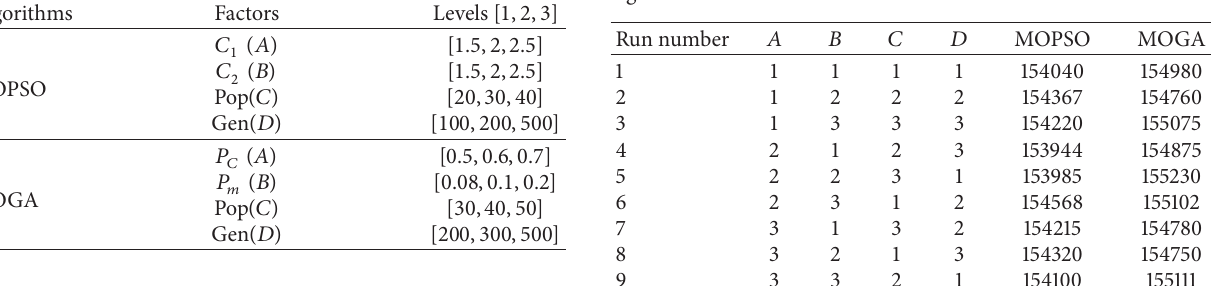
Table 4: The parameters of the two algorithms and their levels. Table 5: The Taguchi 𝐿 9 design along with objective values of the algorithms.